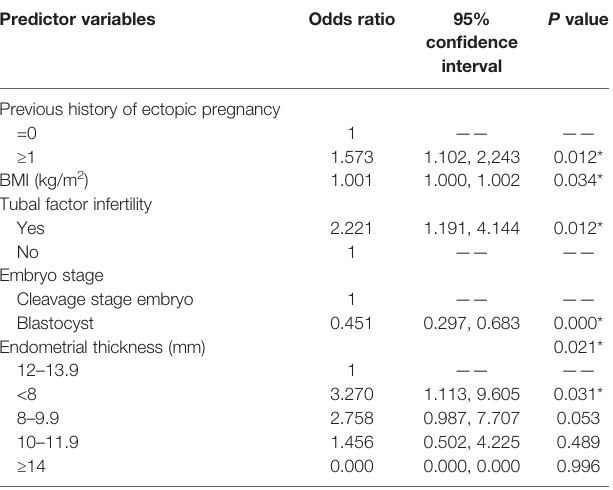
TABLE 3 | Factors associated with ectopic pregnancy based on stepwise multiple regression analysis. Predictor variables